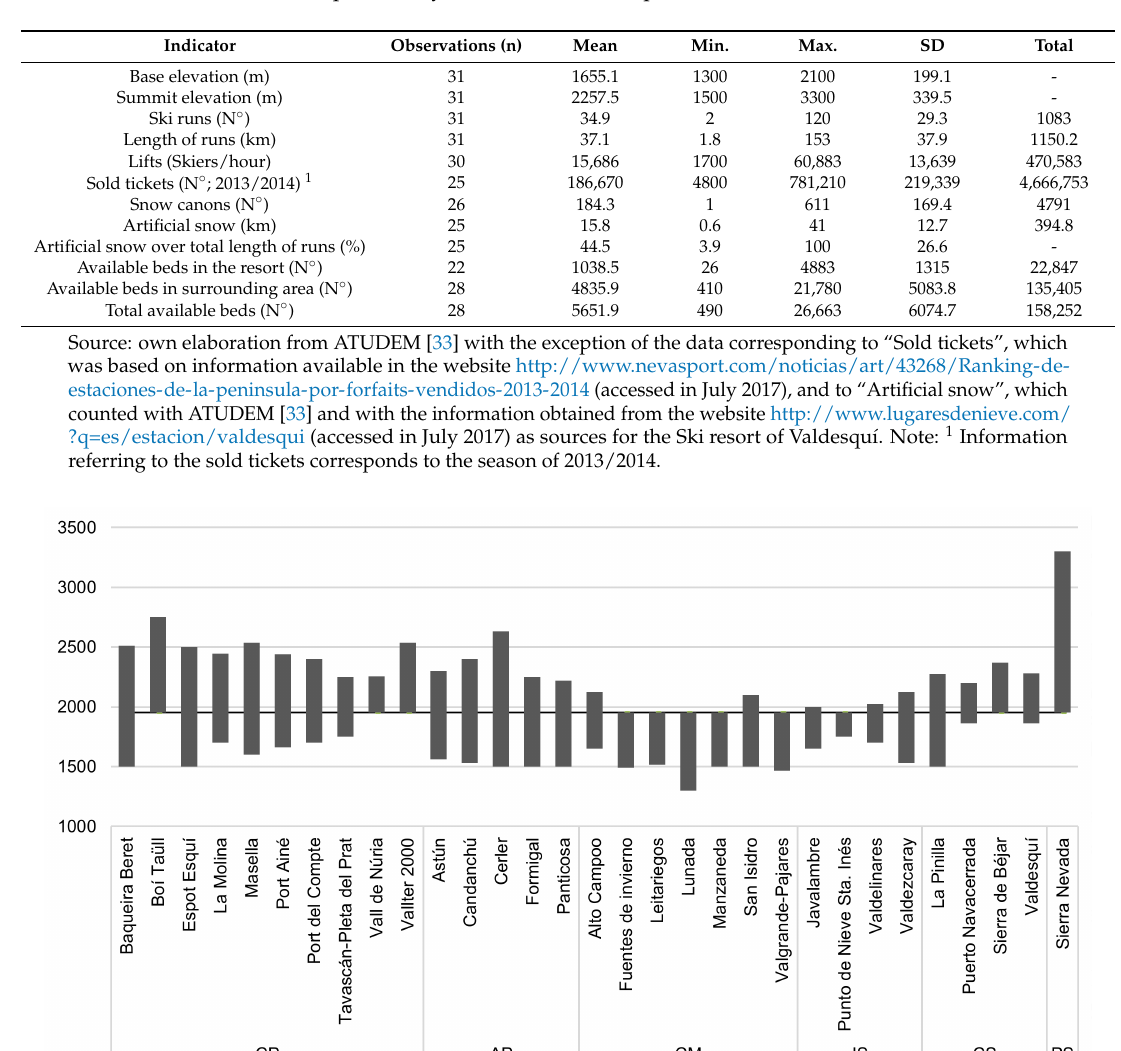
Table 1. Descriptive analysis of ski resorts of Spain, winter season 2014/2015.